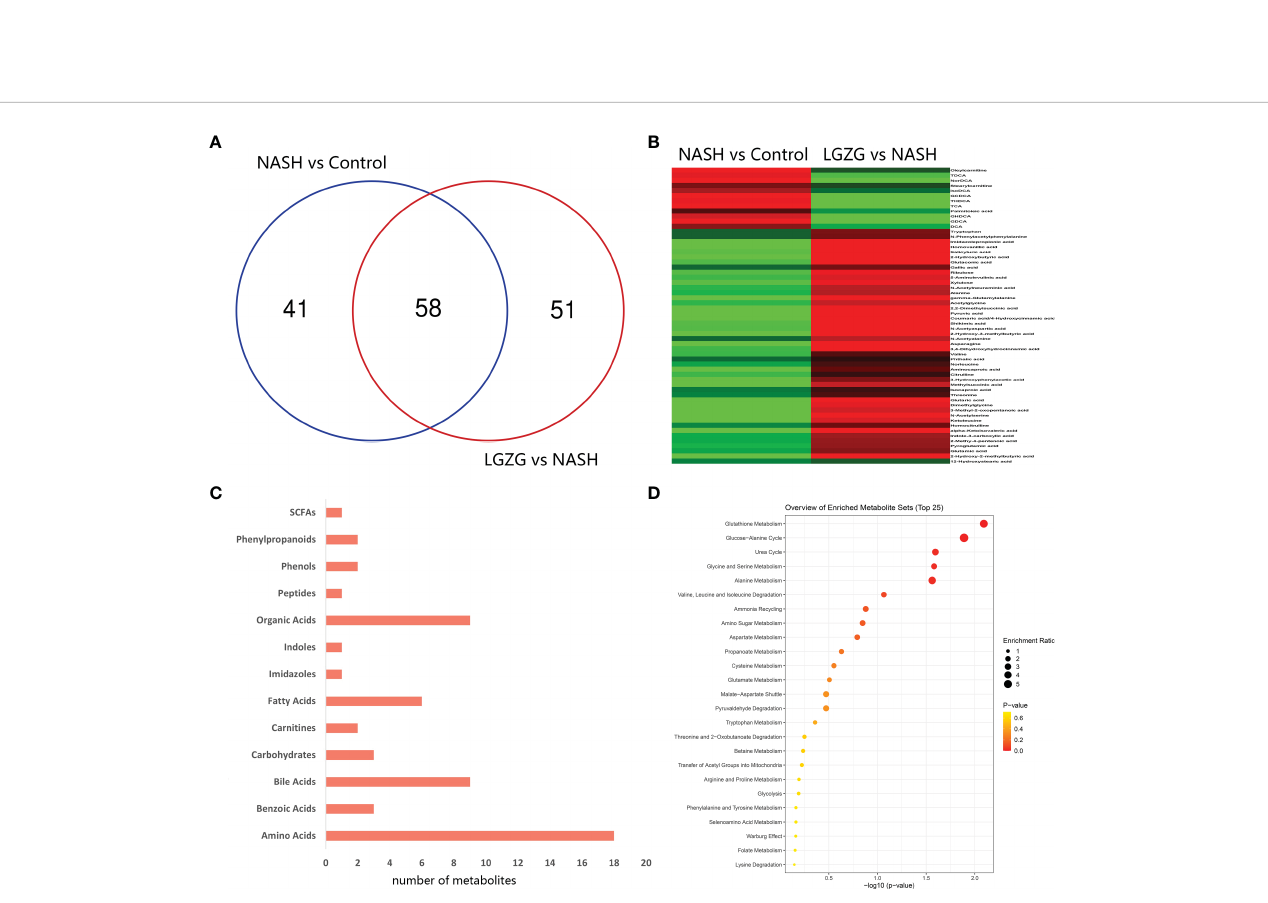
FIGURE 7 Signi fi cantly changed metabolites among groups and enrichment analysis. (A) Venn diagram between the two pairwise groups (NASH vs. Control and LGZG vs. NASH) overlapped 58 signi fi cant changed metabolites, (B) The heatmap showed the cluster analysis of 58 overlapping metabolites; the red color indicated up-regulated metabolites and the green color indicated down-regulated metabolites, (C) 57 LGZG-restored metabolites were grouped into 13 classes, the X-axis represented the number of changed metabolites in the same class and the Y-axis represented different classes, (D) Enrichment analysis of KEGG pathway for 57 LGZG-restored metabolites, the X-axis represented p value, and the Y-axis represented the name of pathway, the size of the dots represented different enrichment ratios and the color represented the different p